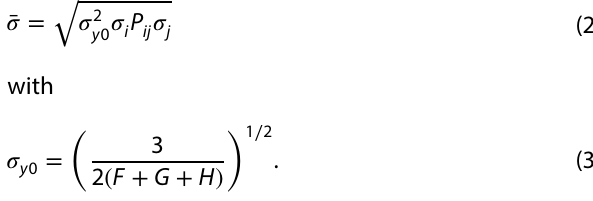
Table 1 Material data for the DC04 steel, used for the skins of the Hybrix™ micro-sandwich